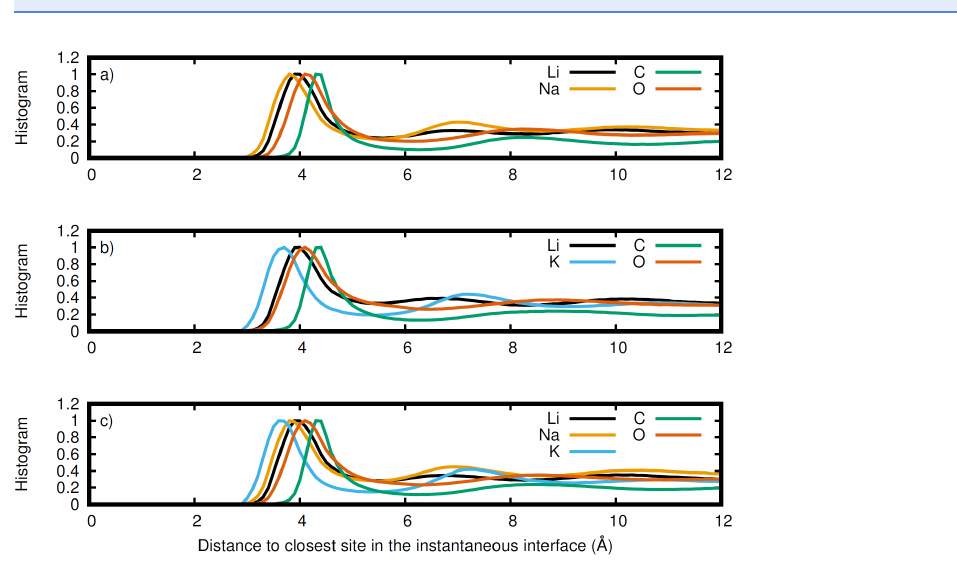
Figure 7 Normalized histogram of the distance of each element from the closest point on the instan- taneous interface. Li (black), Na (orange), K (blue), C (green), and O (red) for the (A) LiNaCO 3 , (B) LiKCO 3 , and (C) LiNaKCO 3 systems are